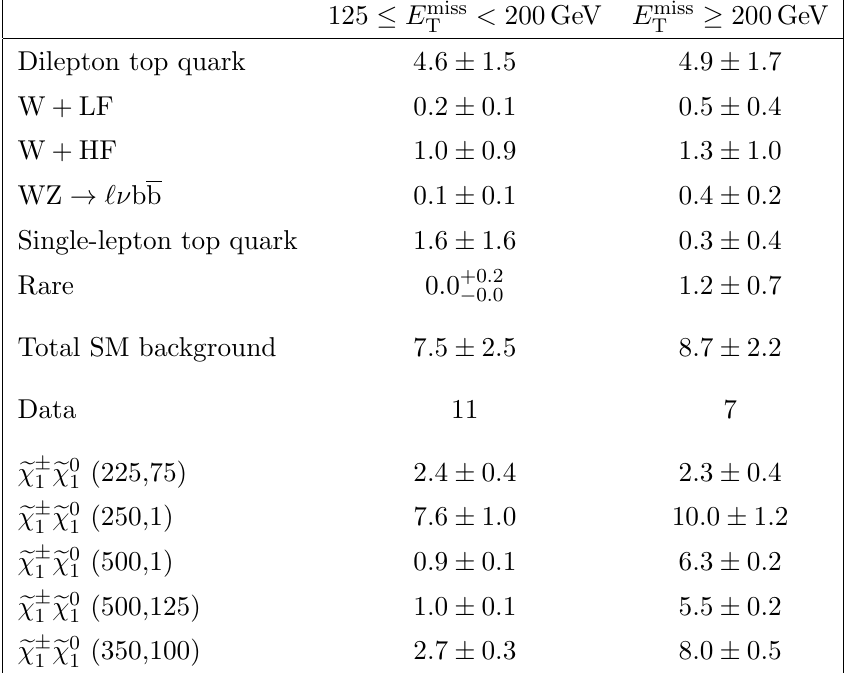
Table 2 . Expected and observed event yields in the signal regions. The uncertainties shown include both statistical and systematic sources. The correlation coe(cid:14)cient for the background prediction between the two bins is 0.61. Predicted yields are shown also for several signal models with the masses ( m ; m ) indicated in GeV and with statistical-only (cid:6) e (cid:31) 0 1 e (cid:31) 1